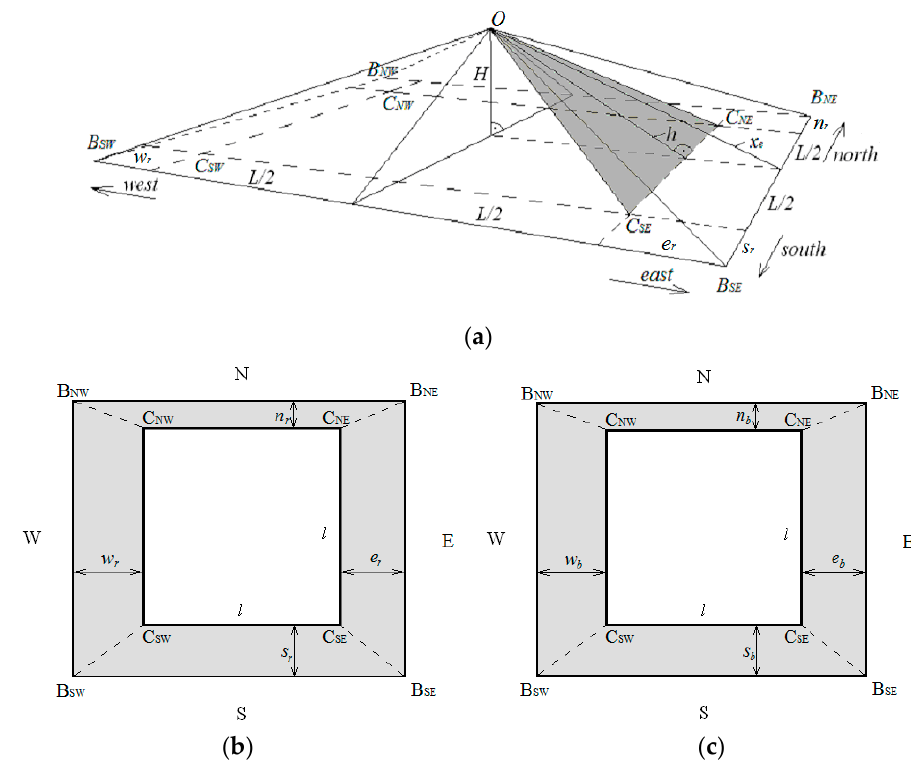
Figure 6. Sketch of roof construction: ( a ) 3d view, ( b ) view from the top of the ORO building and ( c ) view from the top of the OBO building.